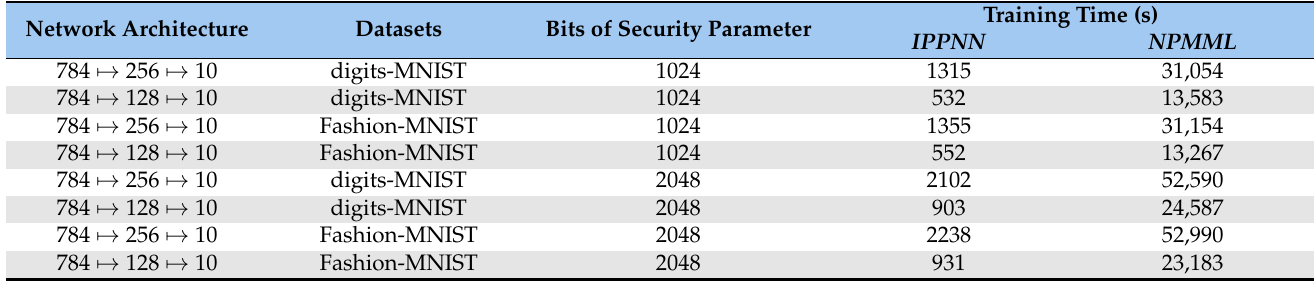
Table 1. Comparison of time cost for training one mini-batch (60 samples).